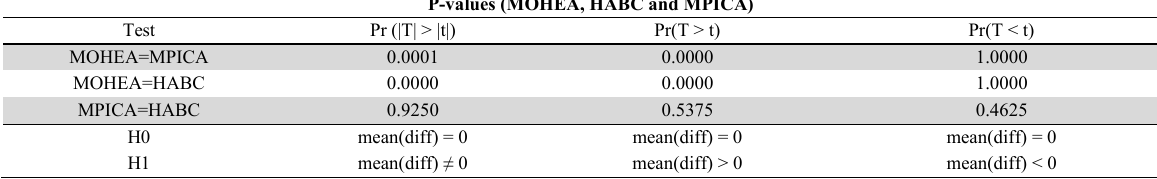
P-values in the difference of means test between MOHEA, HABC and MPICA P-values (MOHEA, HABC and MPICA)